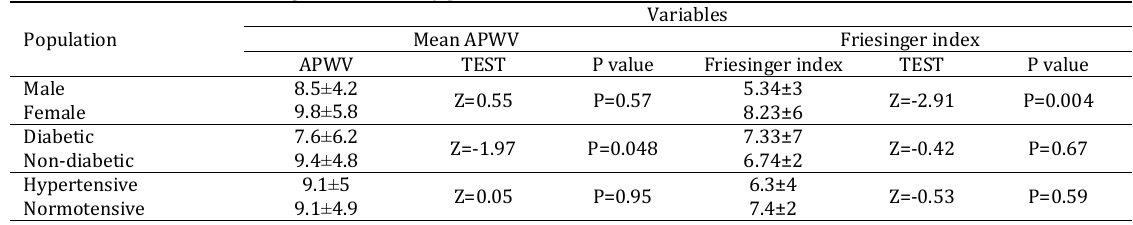
Table 2. Mean APWV and Friesinger index of study patients